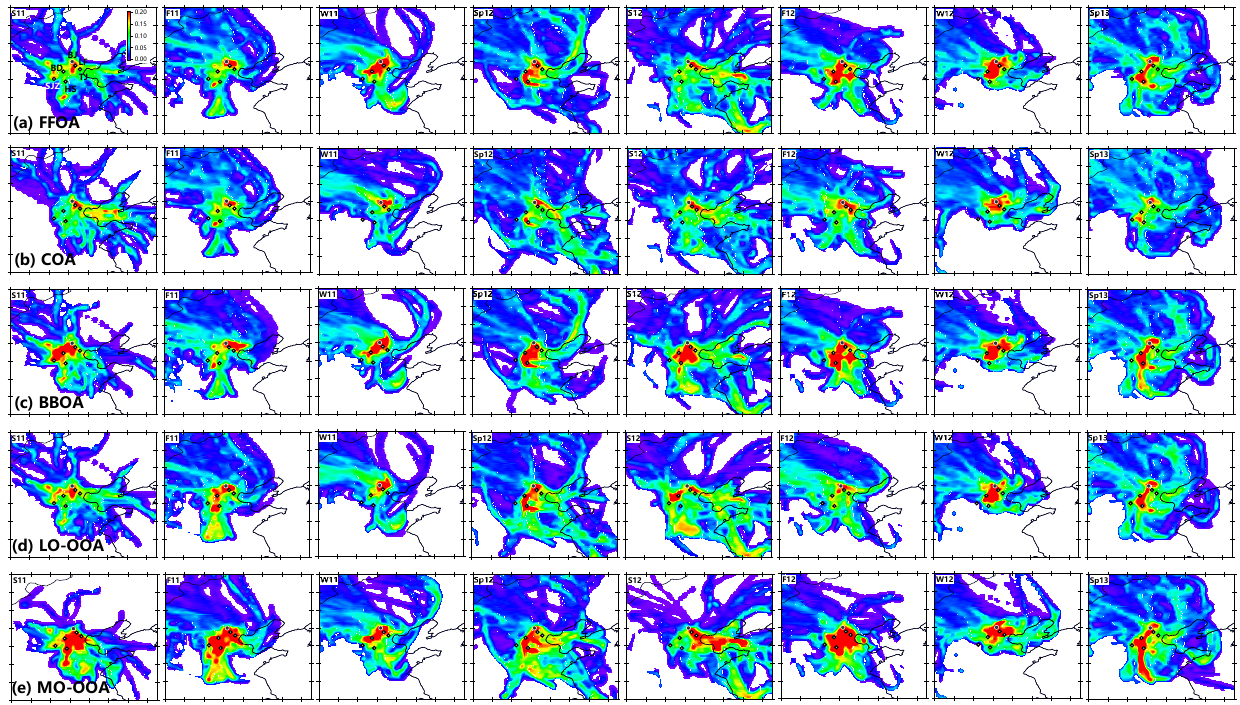
Figure 8. PSCF of five OA factors in each season. The cities marked as solid circles in each panel are Tianjing (TJ), Langfang (LF), Baoding (BD), Shijiazhuang (SJZ), and Hengshui (HS). The color scales indicate the values of